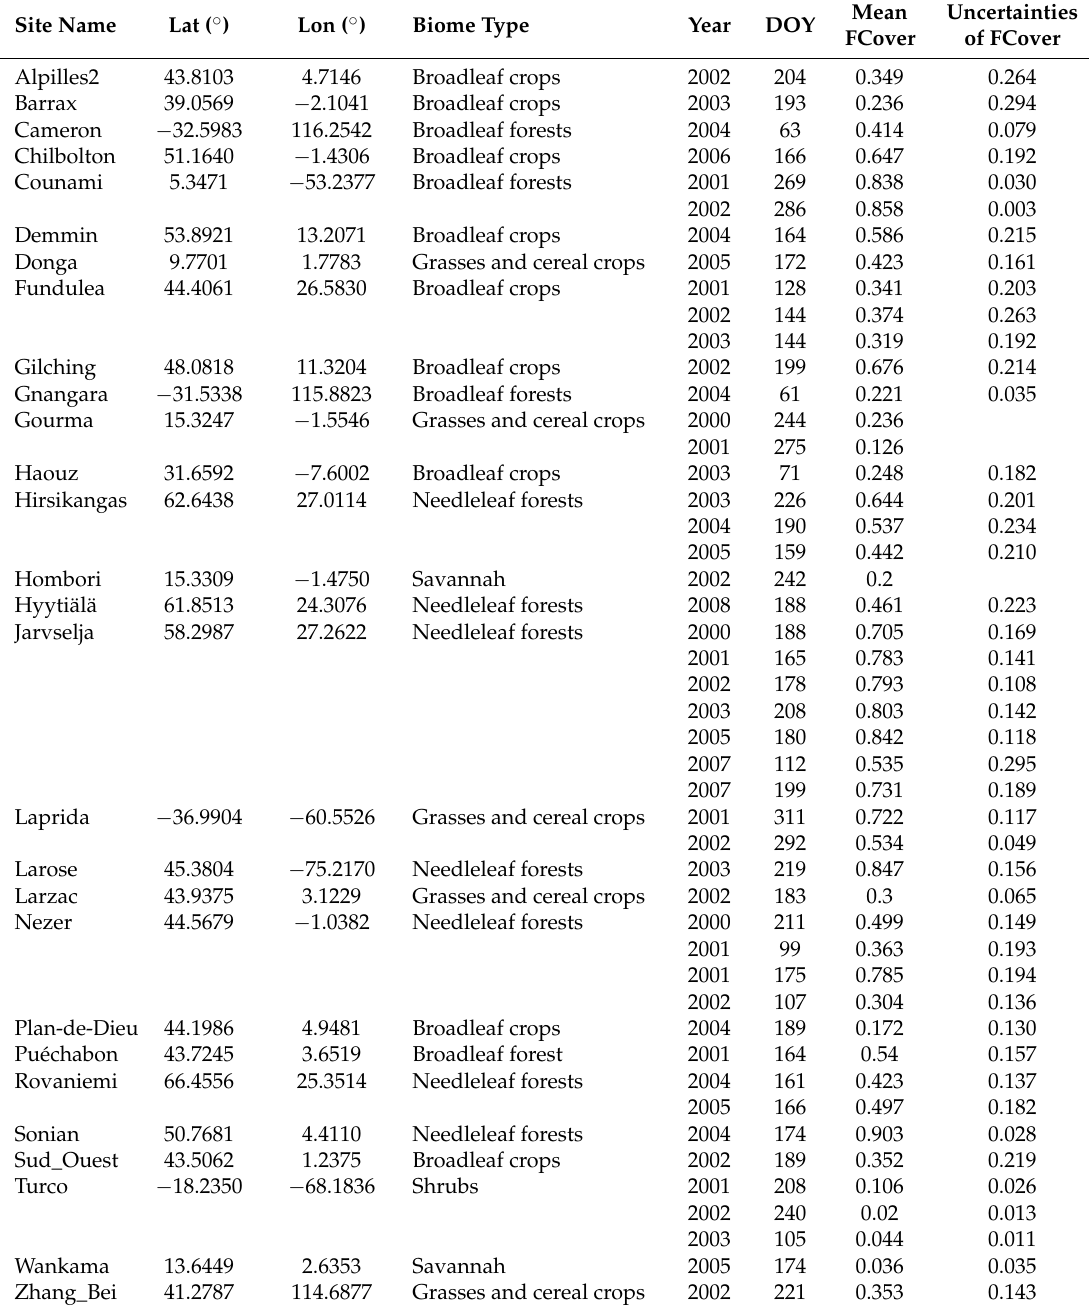
Table 1. Characteristics of the 28 validation